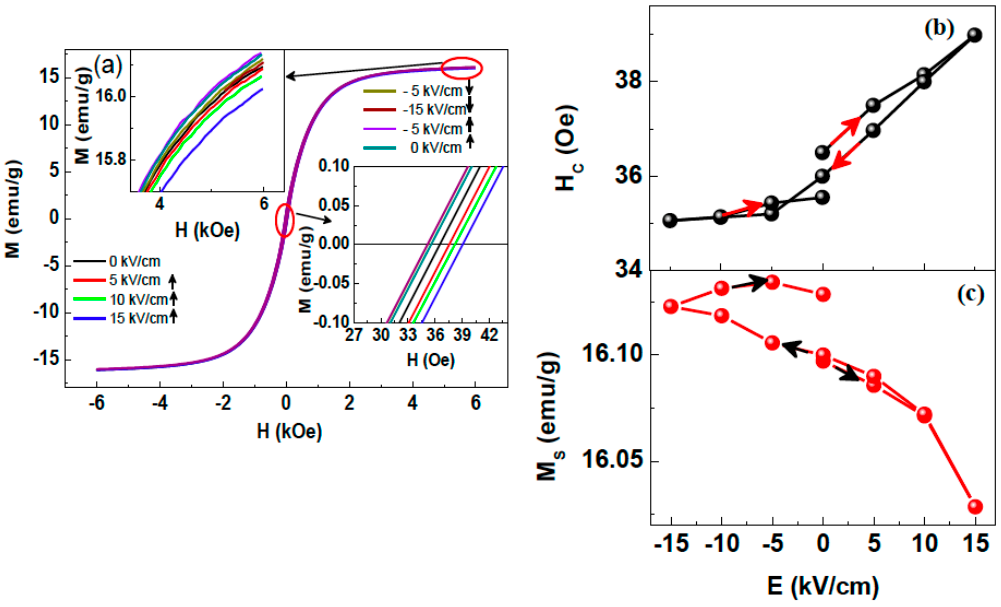
Figure 4. ( a ) M - H loops at different external applied E -fields at RT (Inset: magnified M - H loop at high and low magnetic fields. ( b ) Variation of coercive field ( H c ) ( c ) saturation magnetization ( M s ) with external applied E -fields of PN2 composite (Arrows indicate the direction of E -field). Figure reproduced with permission from [66] .